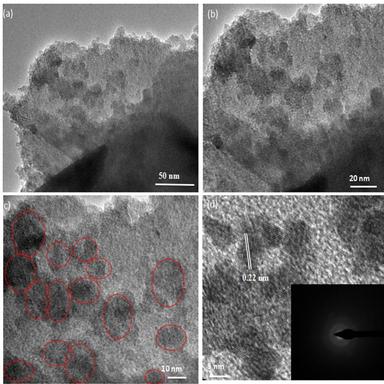
a) XPS survey spectrum of the Co(OH)2/RuO2-2; (b) Co 2p, (c) Ru 3p and (d) O 1s regions of the samples.